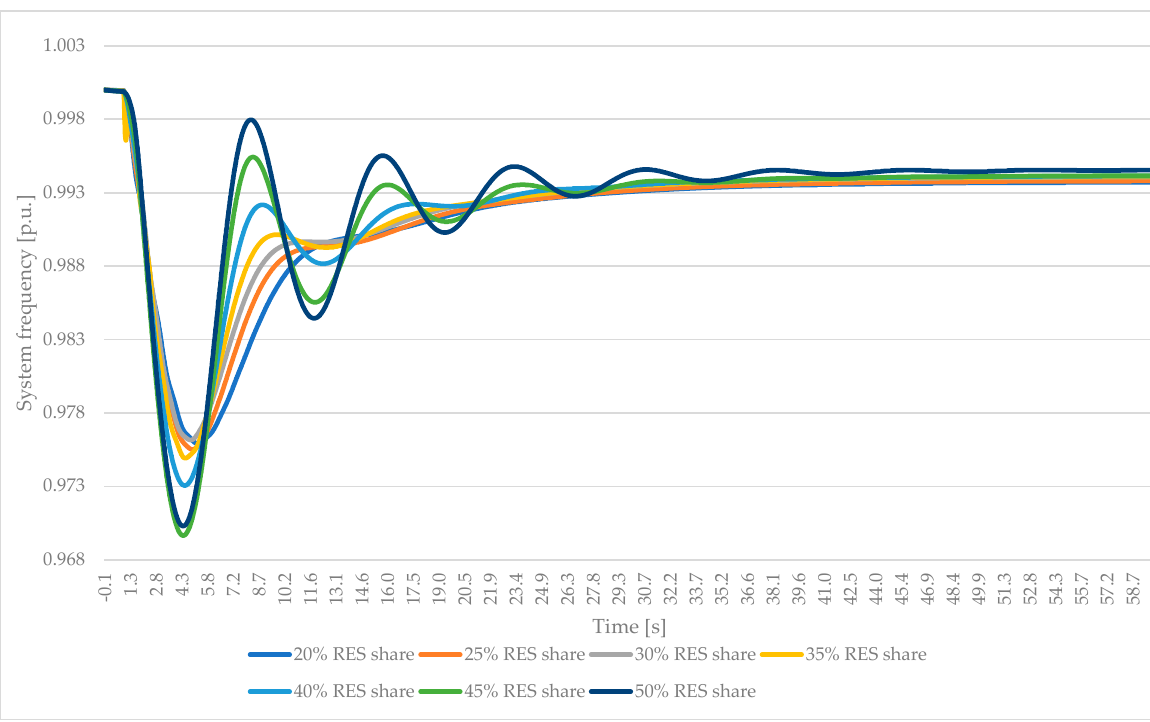
Figure 9. Frequency response for different shares of converter-interfaced RES.